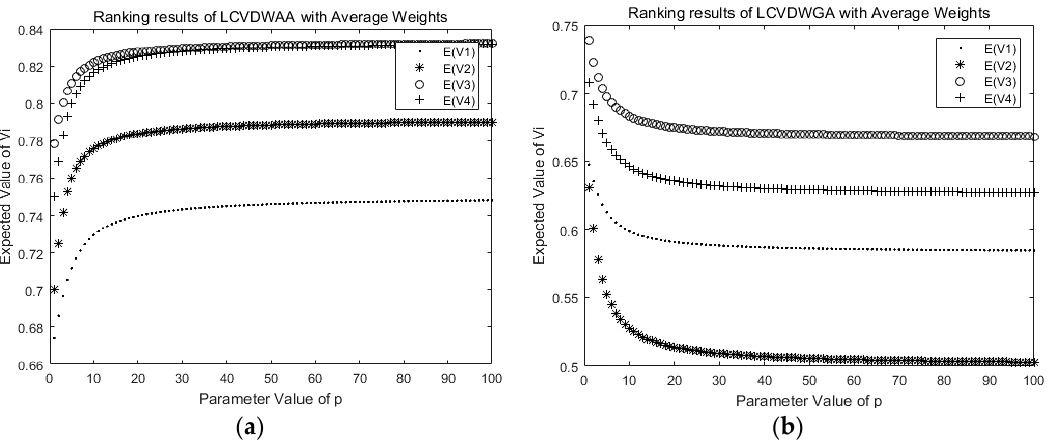
Figure 1. Ranking results with average weights in Example 2. LCVDWAA = linguistic cubic variable Dombi weighted arithmetic average; LCVDWGA = linguistic cubic variable Dombi weighted geometric average. ( a ) LCVDWAA operator; ( b ) LCVDWGA operator.